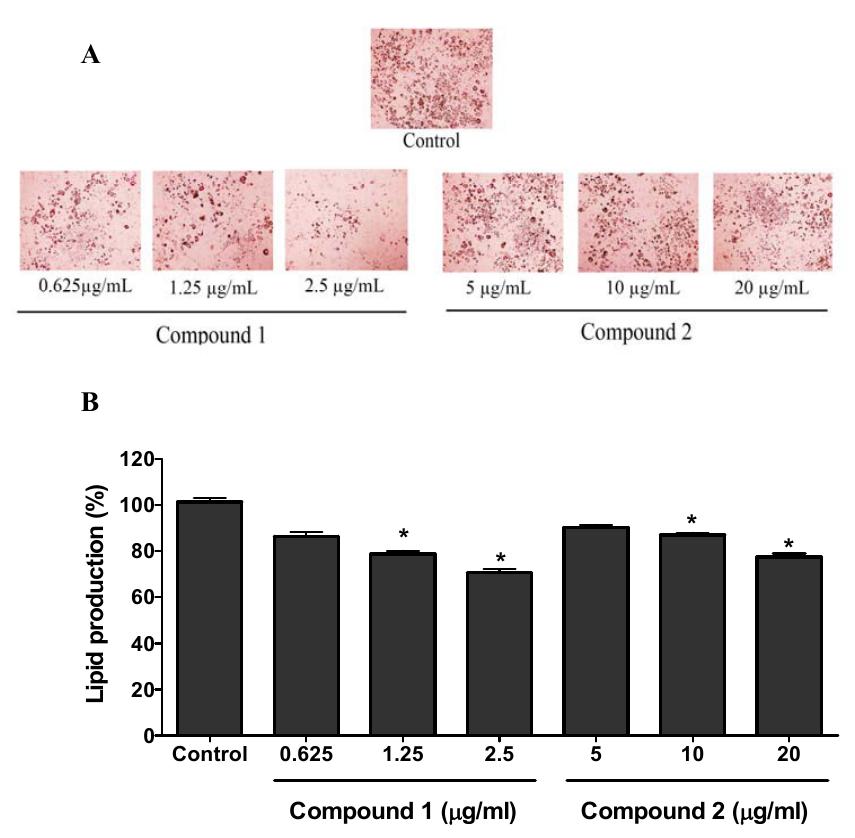
Figure 5. Anti-adipogenic activity of compounds 1 and 2 . 3T3-L1 preadipocytes were cultured and differentiated using differentiating media. Cells were differentiated with or without the presence of compounds 1 and 2 . The production of lipid in the cells was observed by using oil red O (ORO) staining agent ( A ). The ORO stain (red pigments) in the cells were eluted in isopropanol and evaluated for the quantification of lipid production in the cells from each group ( B ). The data show relative mean lipid production percentage ± SD of triplicate experiments. Statistical significance was calculated using one-way ANOVA followed by Dunnett’s test. * P < 0.05 vs. control.